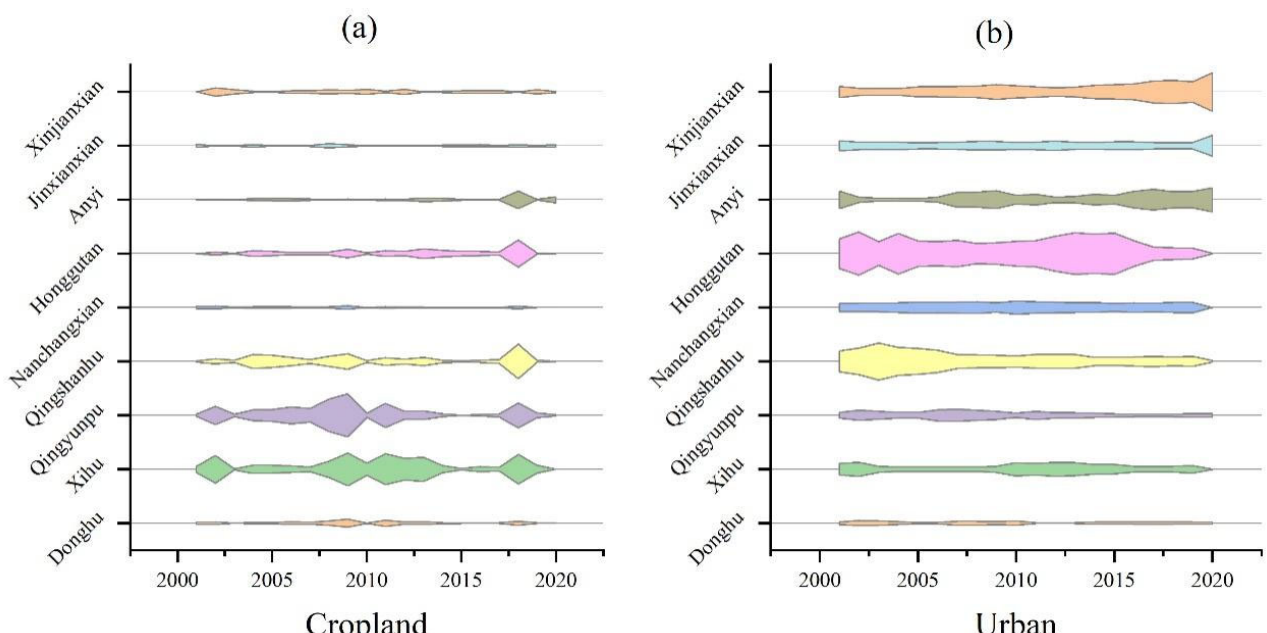
Figure 8. Kite diagram of relative change rates in cropland and urban land use areas. ( a ) the relative change rates in cropland; ( b ) relative change rates in urban.